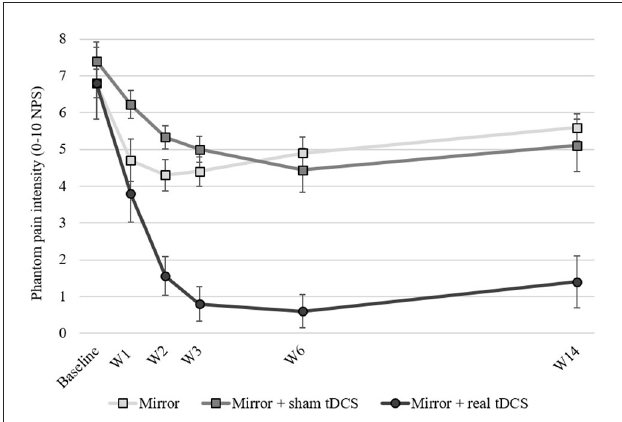
FIGURE1 Phantom pain intensity at baseline, across treatment weeks and up to 3 months following the end of treatment. W1, during 1st week of treatment; W2, during 2nd week of treatment; W3, 1st week following end of treatment; W6, 1-month following the end of treatment; W14, 3-months following the end of treatment. tDCS, transcranial direct current stimulation; NPS, numerical pain scale. Error bars represent the Standard Error of the Mean